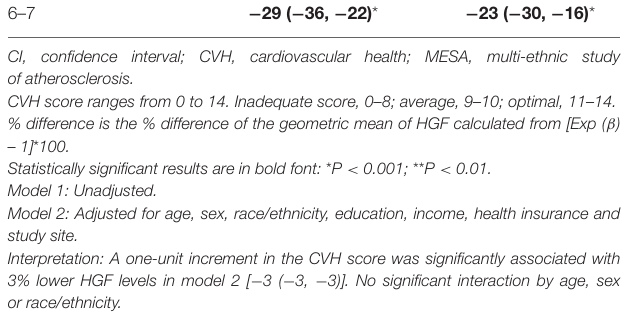
FIGURE 1 | Box plot of HGF by CVH scores. The lower and upper boundaries of the rectangles denote the 25th and 75th percentiles while the horizontal line within the rectangles is the median. Lines extend from the rectangles to the smallest and largest values within 1.5 × interquartile range.